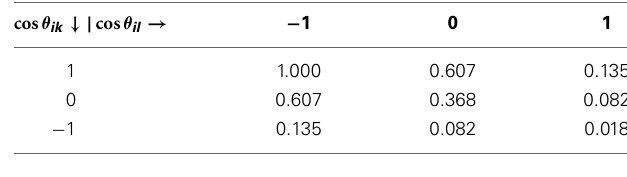
Table 1 | Extremal values of the angular potential V ikl ≡ e − ( W ik + W il ) / 2 σ 2 θ , corresponding to cos( θ ik ) = 1 , 0 , 1 and cos( θ il ) = 1 , 0 , 1 for the case σ θ = 1.